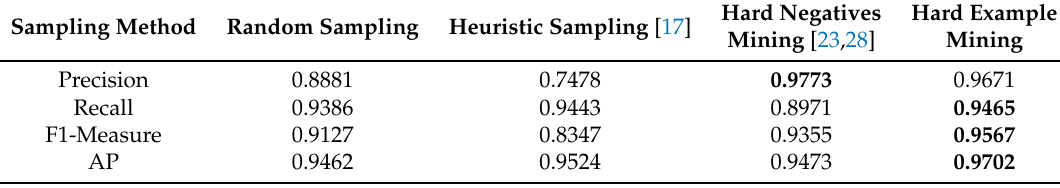
Figure 10. Comparison of the different sampling methods on final detection. Table 4. Comparison of the different sampling methods on final